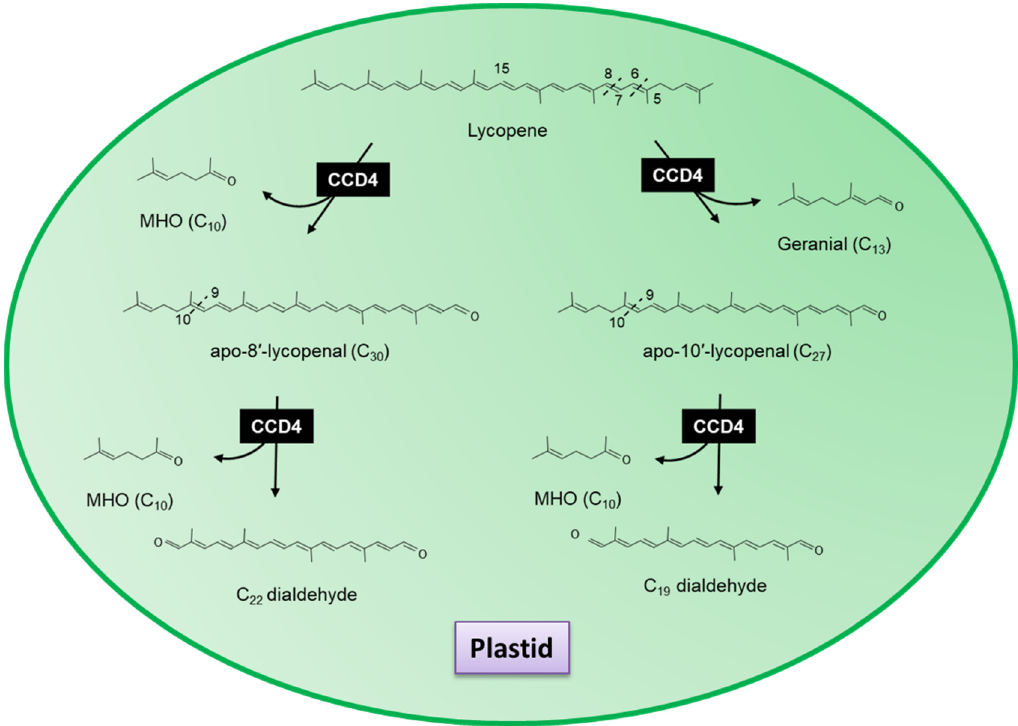
Figure 6. Scheme for the 5,6(5 ′ ,6 ′ ,) and 7,8(7 ′ ,8 ′ ,) cleavage of lycopene by CCD4 (MHO; 6-methyl-5-hepten-2-one) and the 9,10(9 ′ ,10 ′ ,) cleavage of the generated apocarotenoids in a second step.